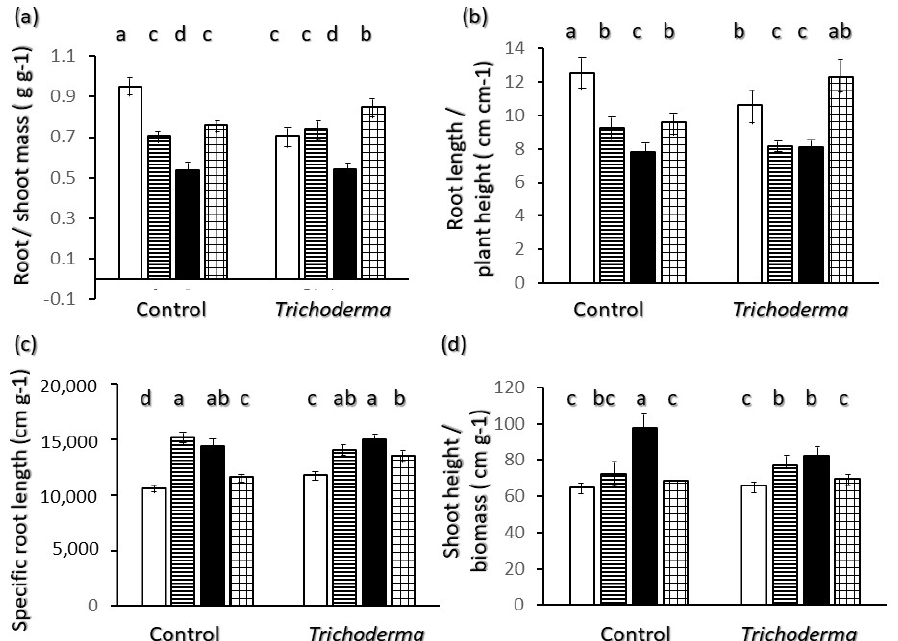
Figure 6. Interaction of wheat variety x Trichoderma harzianum T-22 inoculation on Allometric rela- tions of plant parts: ( a ) root to shoot mass ratio n = 6; ( b ) root length to plant height ratio Vertical segments on each bar indicate standard deviation n =3; ( c ) specific root length n = 3; ( d ) shoot height to biomass ratio n = 6. Color code of bars: white = Ciclope; horizontal stripes = Creso; black = Sar- agolle; grid = Simeto. Different letters on each bar designate significantly different values for p < 0.05 at the Tukey’s post hoc mean separation test.